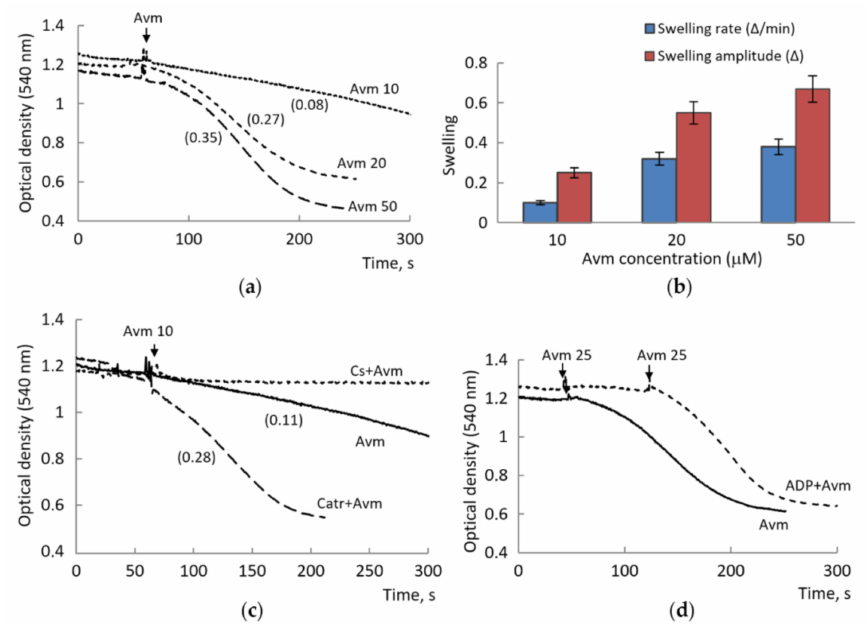
Figure 4. Influence of avermectin on the mitochondrial swelling. The influence of avermectin (Avm) at concentration 10, 20 and 50 µ M on the swelling of mitochondria ( a ) and swelling rates and amplitudes ( b ); the influence of cyclosporin A (Cs, 2 µ M) and carboxyatractyloside (Catr, 2 µ M) on the swelling induced by 10 µ M avermectin ( c ); the influence of ADP (25 µ M) on the avermectin-induced swelling ( d ). The swelling rate ( ∆ /min) is indicated in parentheses. Amplitude values are given in units of change in optical density for 200 s or upon reaching the stop of swelling. Swelling rates are given in units of change in optical density per